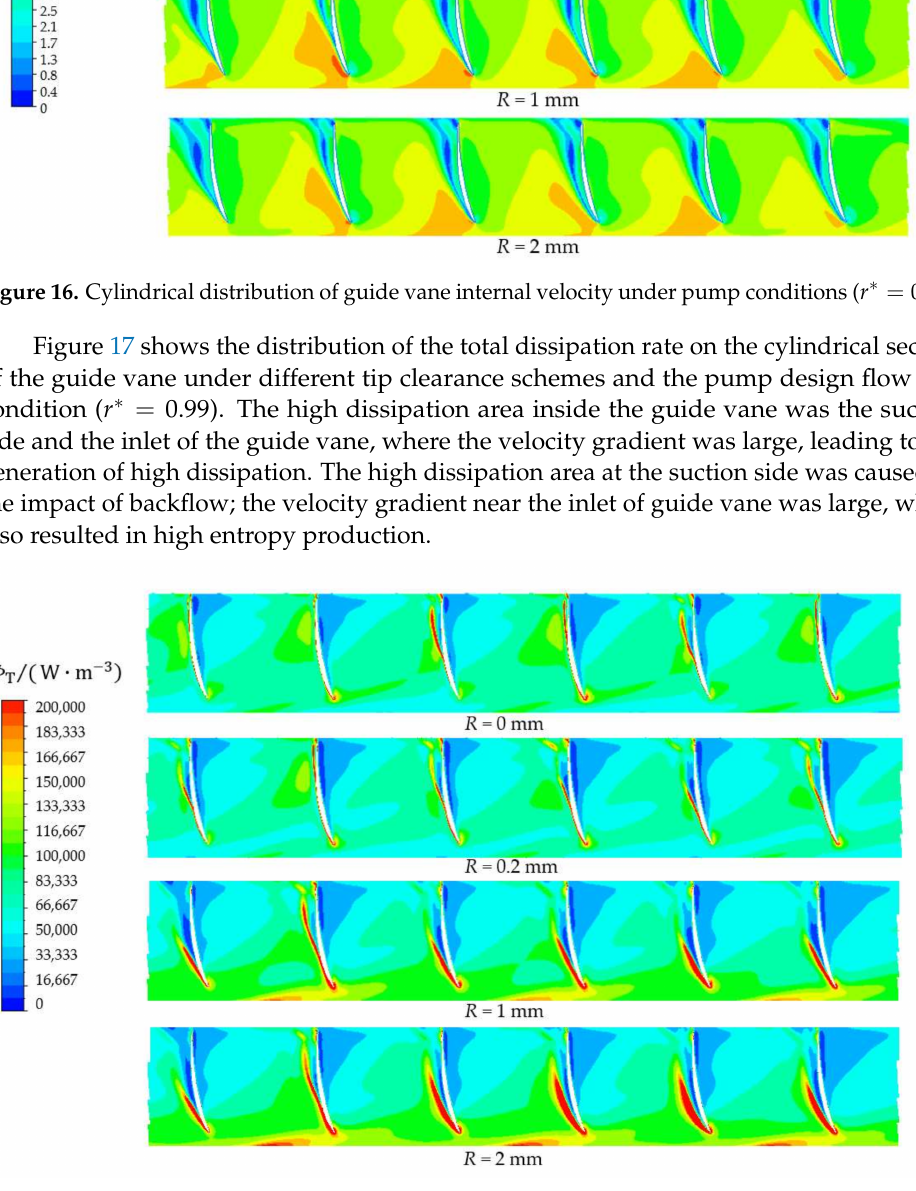
Figure 17. Cylinder distribution of internal dissipation rate of guide vane under pump condition ( r ∗ =